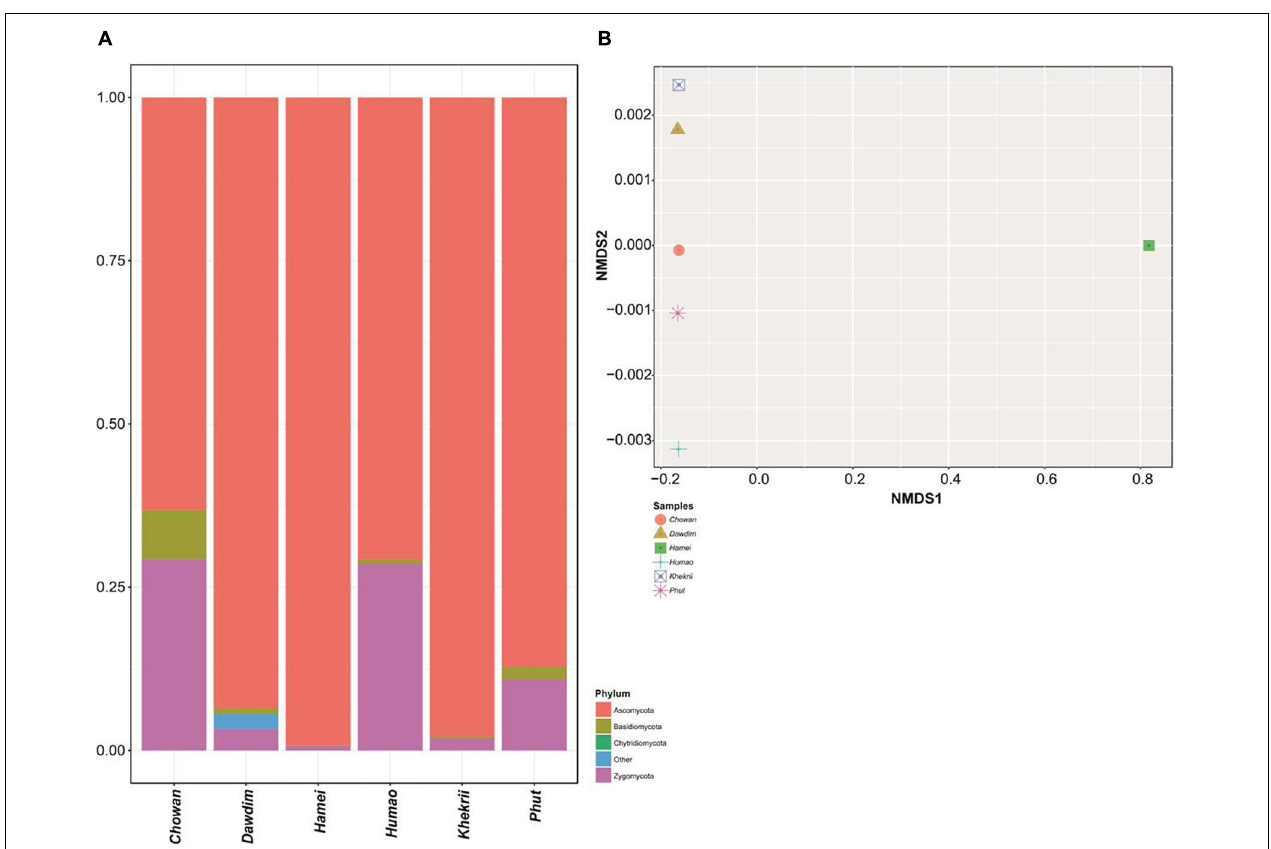
FIGURE 2 | (A) Barplot showing the phylum level diversity and their abundance distribution found in starters. (B) NMDS plot showing the beta diversity clustering pattern in tested subjects.